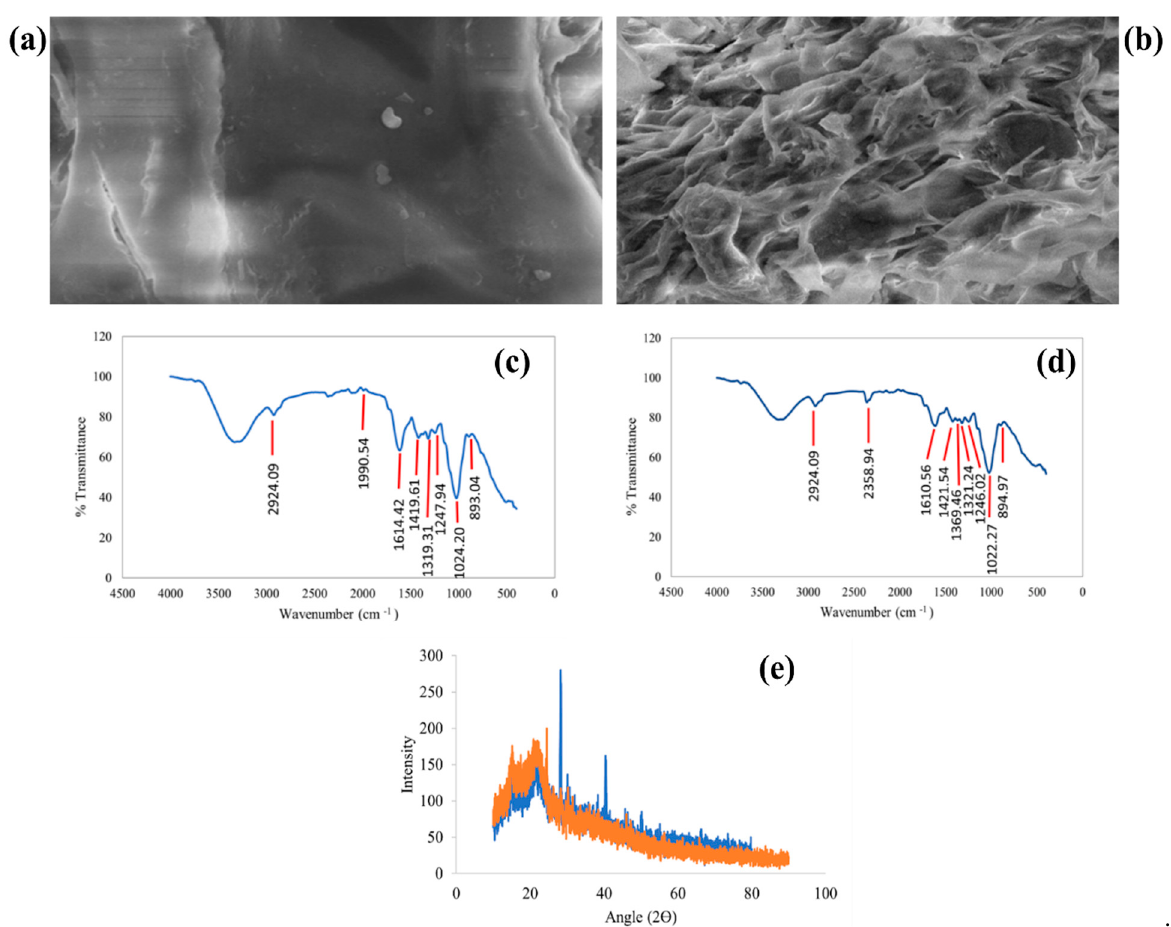
Figure 3. SEM image of ( a ) raw WH and ( b ) DES-pretreated WH. ( c ) FTIR spectra of raw WH and ( d ) FTIR spectra of DES-pretreated WH. ( e ) XRD spectra of raw WH (blue) with WH after DES pretreatment (orange) (pretreatment conditions include biomass:DES—1:12.5; time—4.63 h and temperature—87 ◦